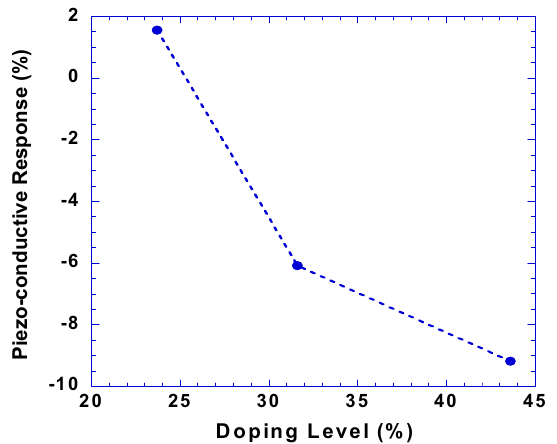
Figure 8. The piezo-conductive responses of the PEDOT:Tos thin films with different doping levels of